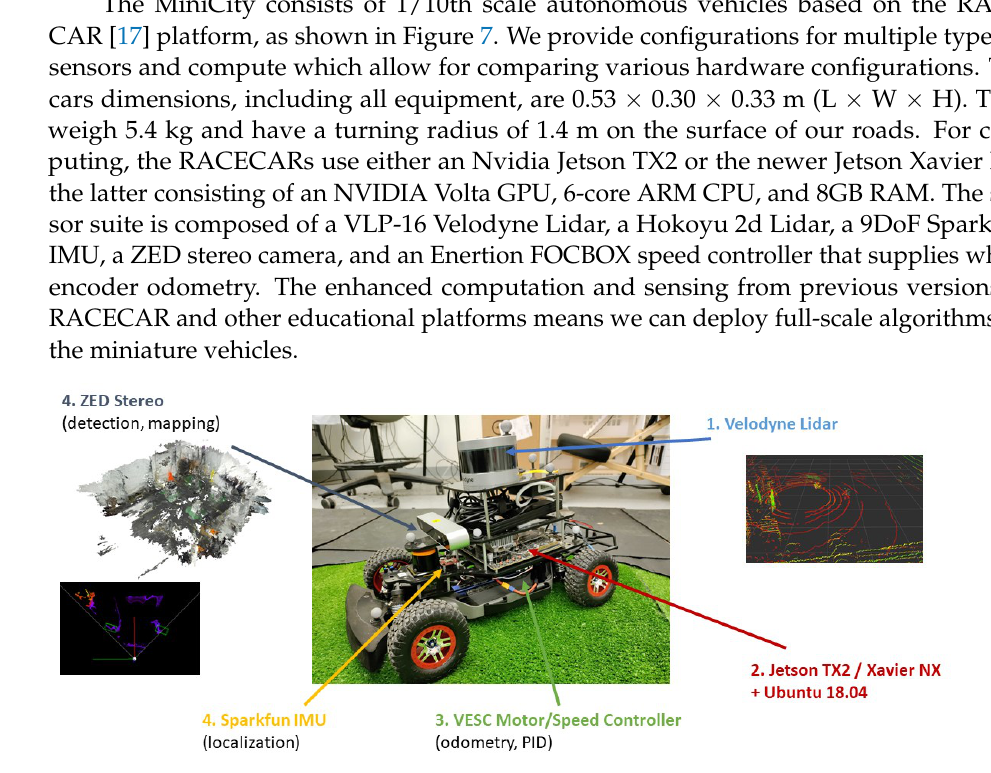
Figure 7. RACECAR Hardware